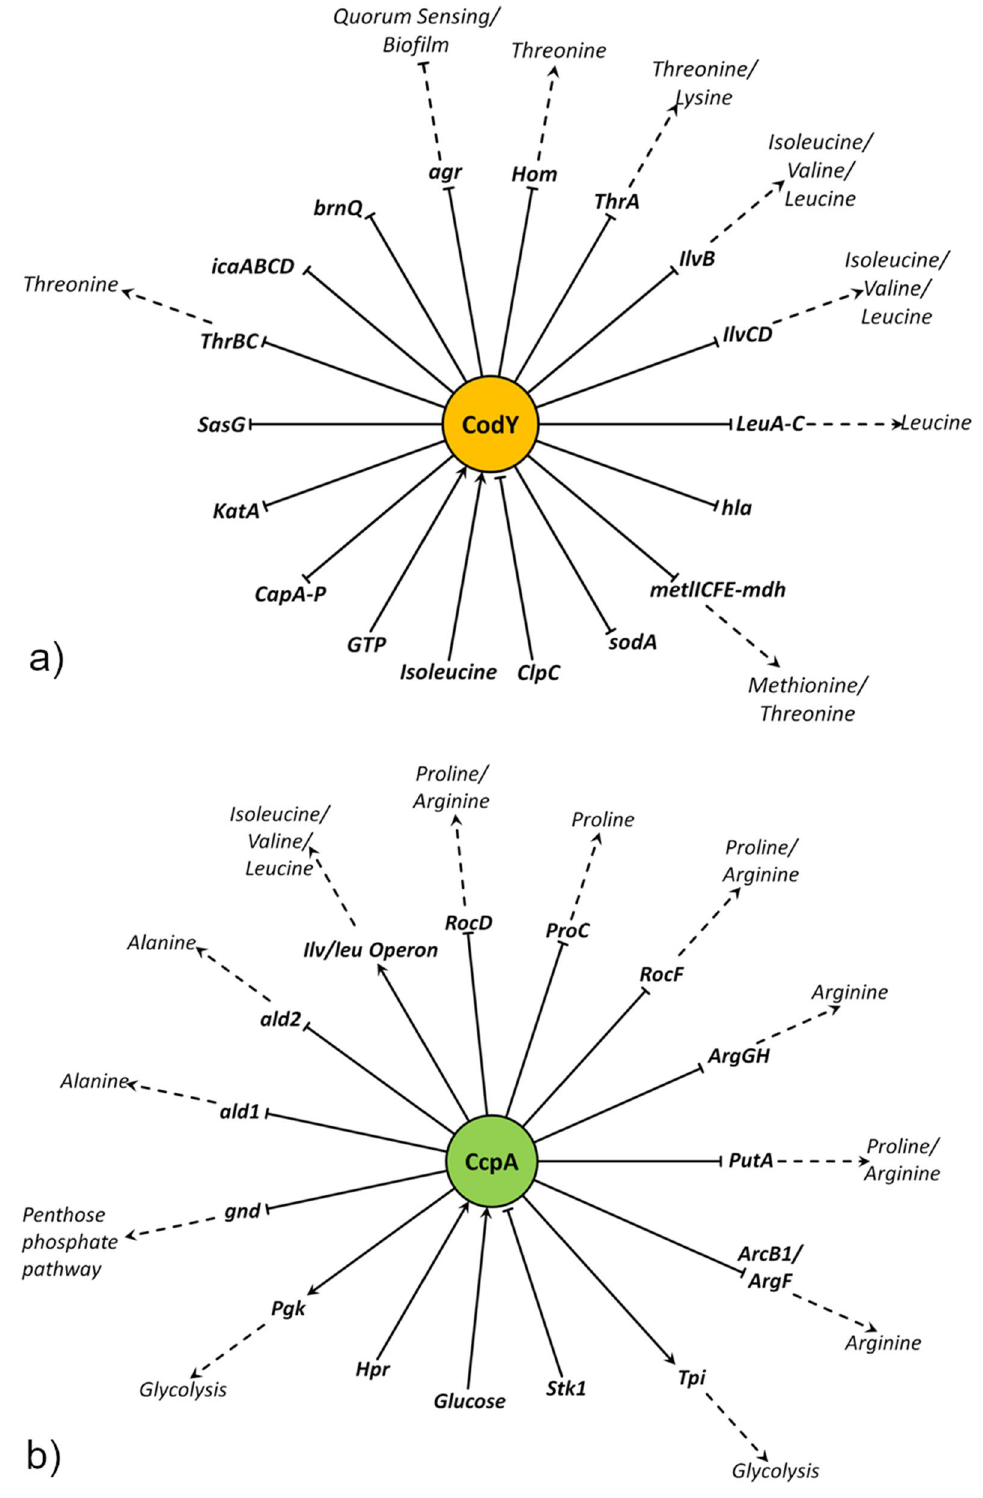
Figure 4. Efferent and afferent connections of CodY and CcpA : The efferent and afferent activating and inhibiting connections of CodY and CcpA are shown here as well as their influence on the